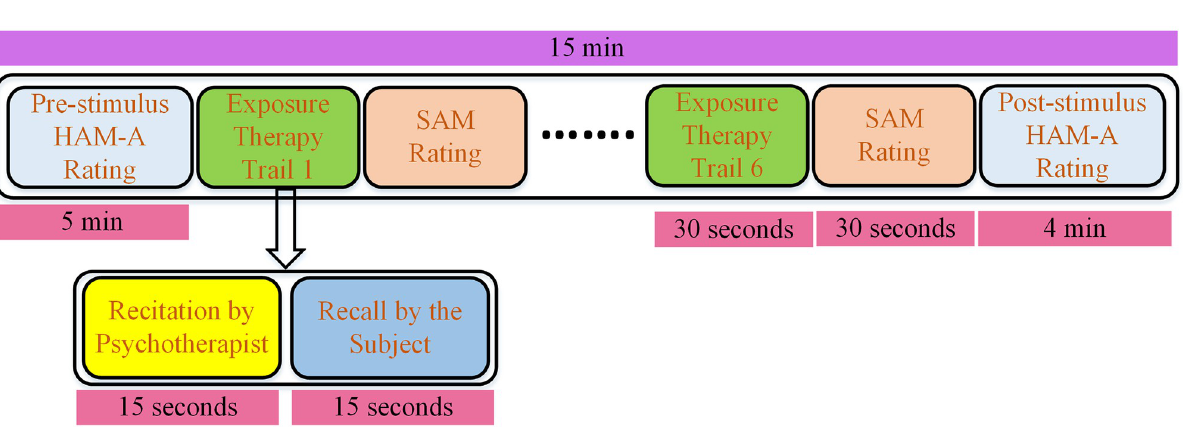
Fig 2. Timing diagram of the data acquisition protocol followed in DASPS